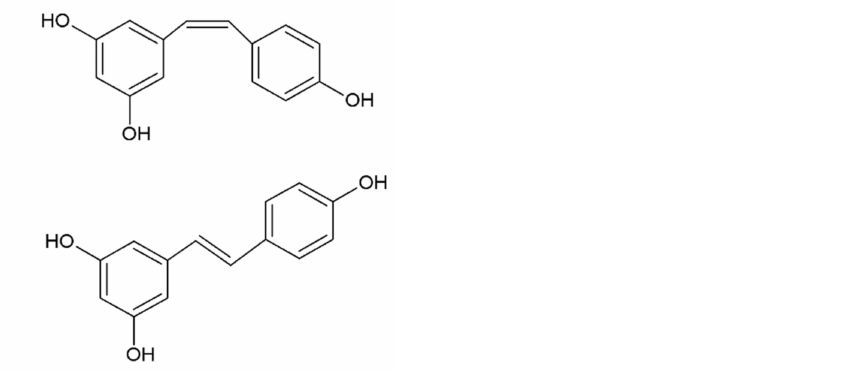
Figure 1. Chemical structures of resveratrol isomers: ( A ) cis -resveratrol, ( B ) trans